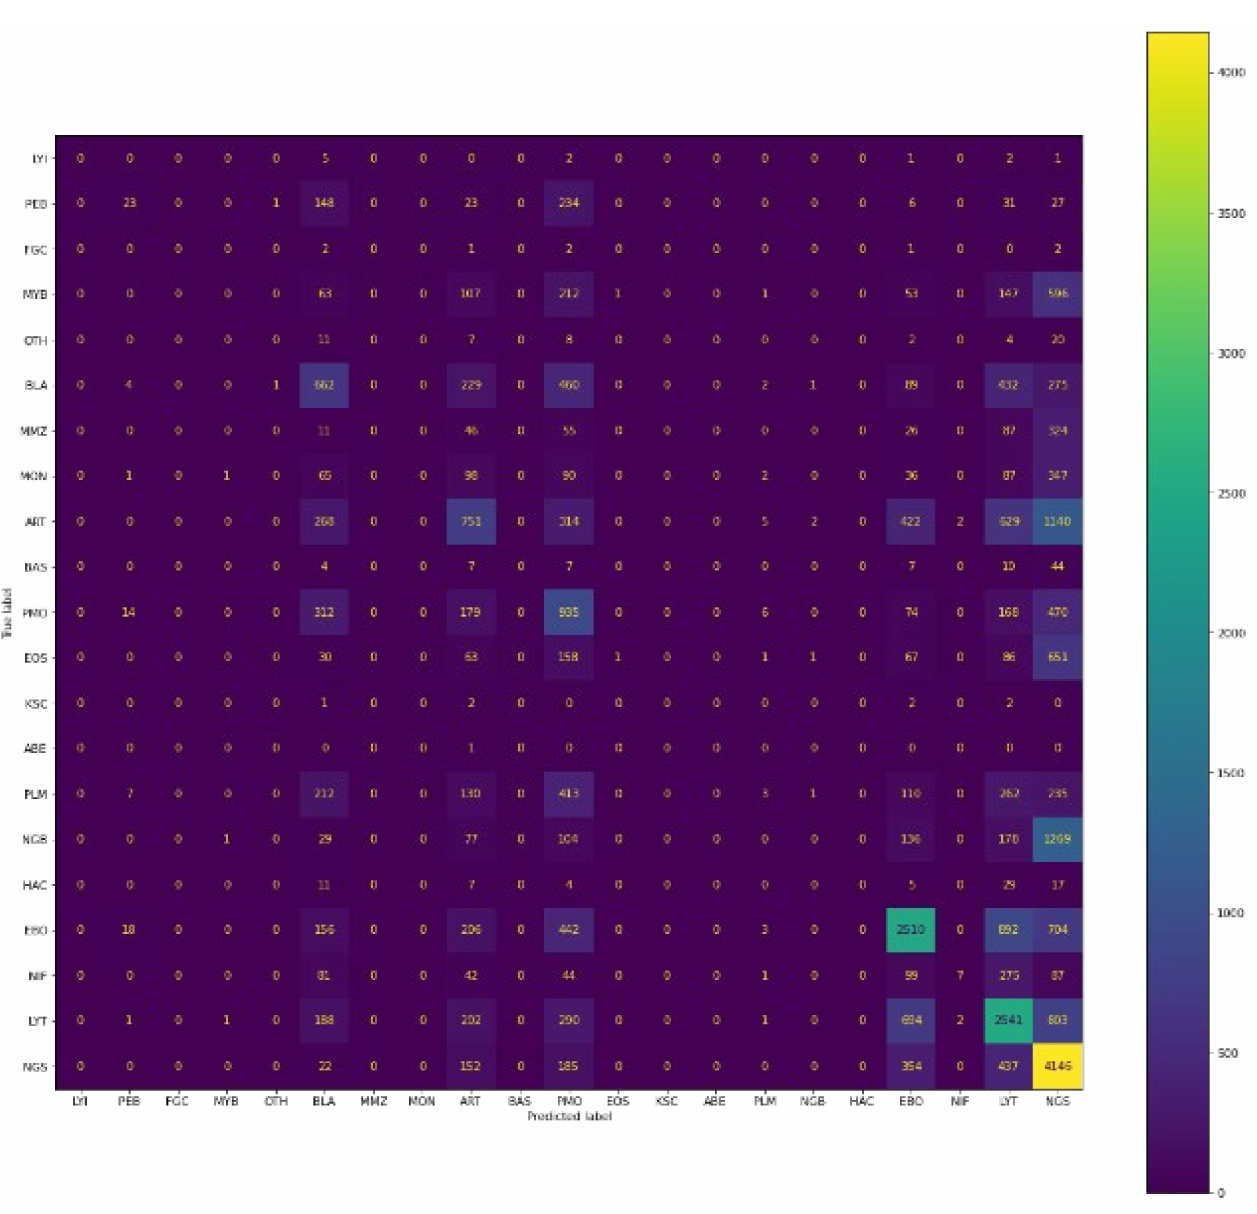
Figure 14. Confusion matrix of predictions generated by